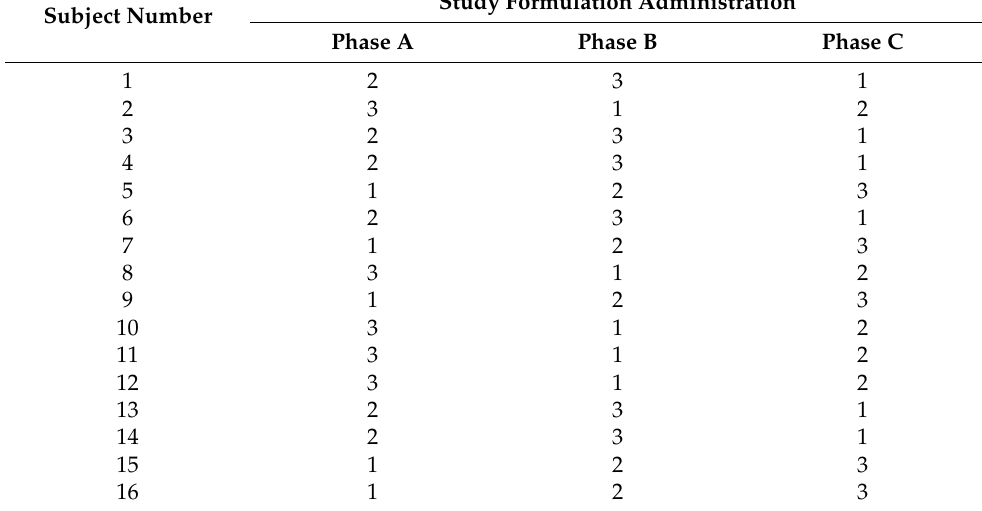
Table A4. Randomization list.